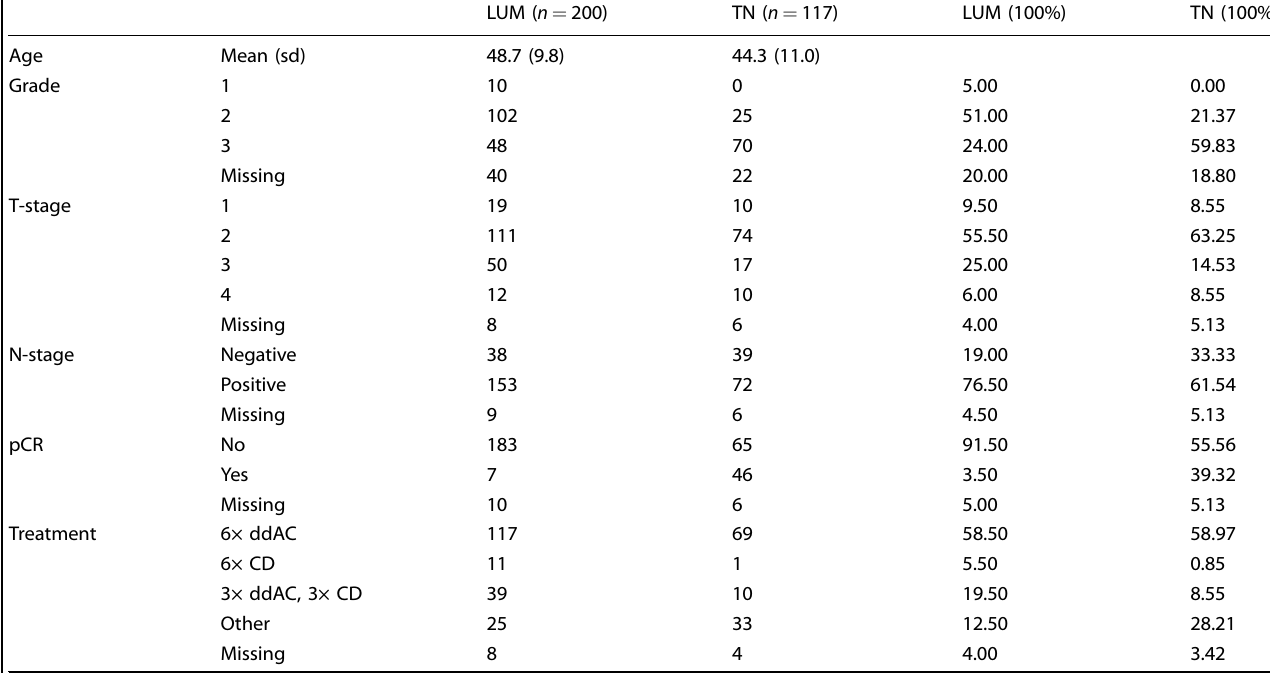
Table 1. Patient characteristics of the full cohort of 317